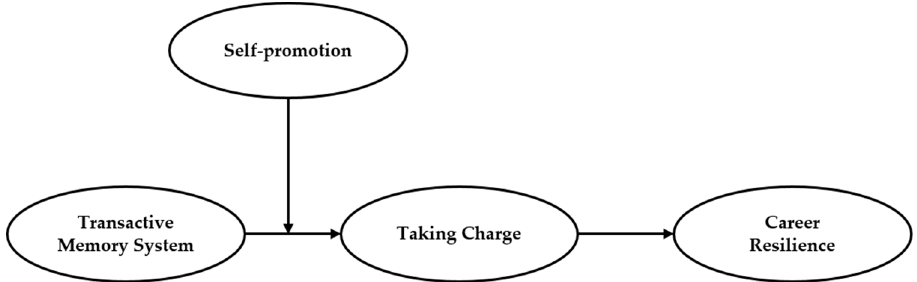
Figure 1. Hypothesized model of the processes linking a transactive memory system (TMS) to career resilience (CR) through taking charge and self-promotion.